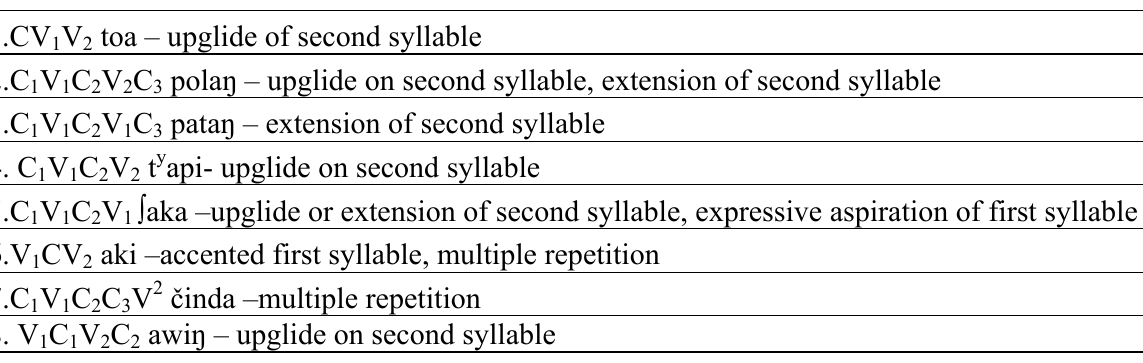
Table 5. Disyllabic ideophone